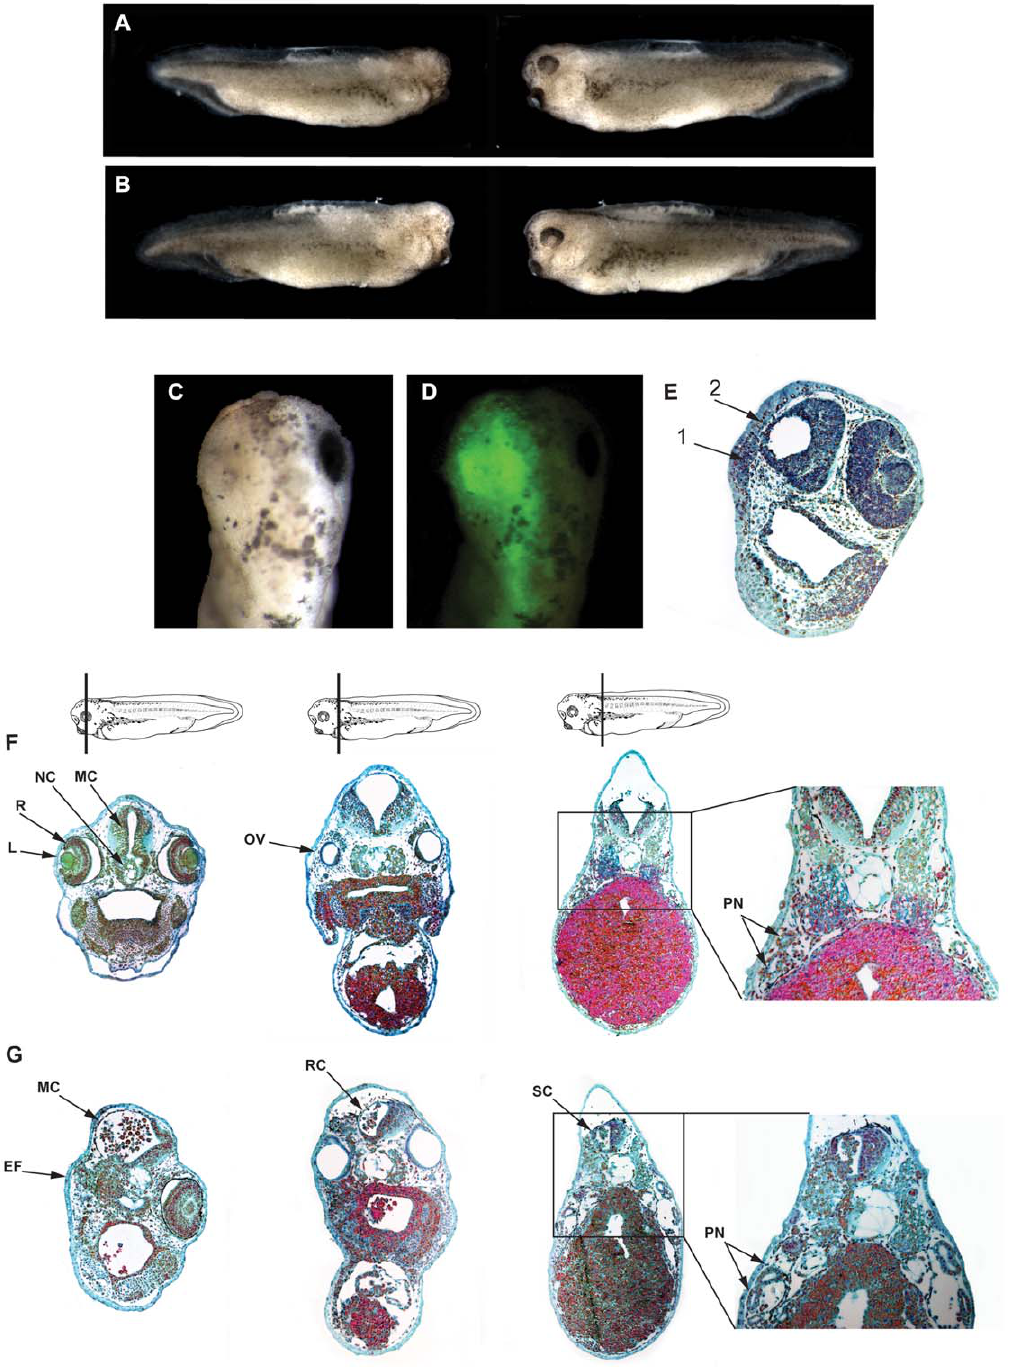
Figure 3. SPC7 antisense morpholino oligonucleotide causes dose-dependent disruption of eye and brain development . (A, B) Embryos injected unilaterally with antisense SPC7-MO at the two cell (A) or four cell stage (B). Injected side is shown on the left. Both the two cell and four cell stage loss-of-function SPC7 experiments resulted in the same phenotype: lack of eye, lack of branchial arches, and diminished head structures on the MO-injected side. The morphology of the rest of the embryo appeared normal. (C) Dorsal view of tadpole-stage embryo injected at the four cell stage with 90 ng MO; the eye appears to be completely absent on the injected side. (D) Same embryo as in C showing MO location on the left. (E) Frontal section of embryo in C and D showing total loss of eye and mesencephalon on the SPC7-MO injected side. The uninjected side was unaffected. Arrows 1 and 2 show presumptive eye field and mesencephalon, respectively, on the MO injected side. In each experiment, embryos injected with control MO developed normally (not shown). (F, G) Histological analysis of control-MO injected (F) and SPC7-MO unilaterally-injected (G, injected side to the left) stage 35 embryos. The planes of section presented are shown diagrammatically at the top. As noted previously, the eye and brain are severely dysmorphic on the injected side; the otic vesicle and pronephros appear normal. (L= Lens; R=Retina; NC=Notochord; MC=Mesencephalon; RC=Rhombancephalon; SC= Spinal Cord; OV=Otic Vesicle; PN=Pronephros; EF=Eye Field).